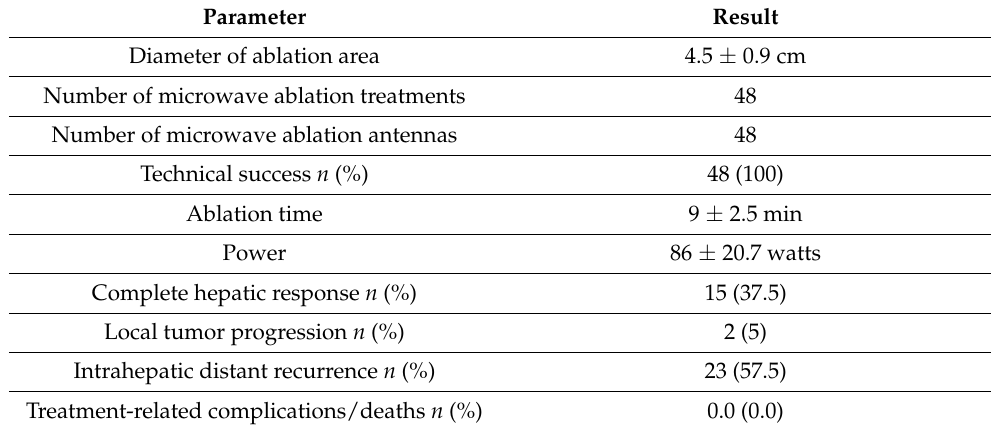
Table 2. Results.